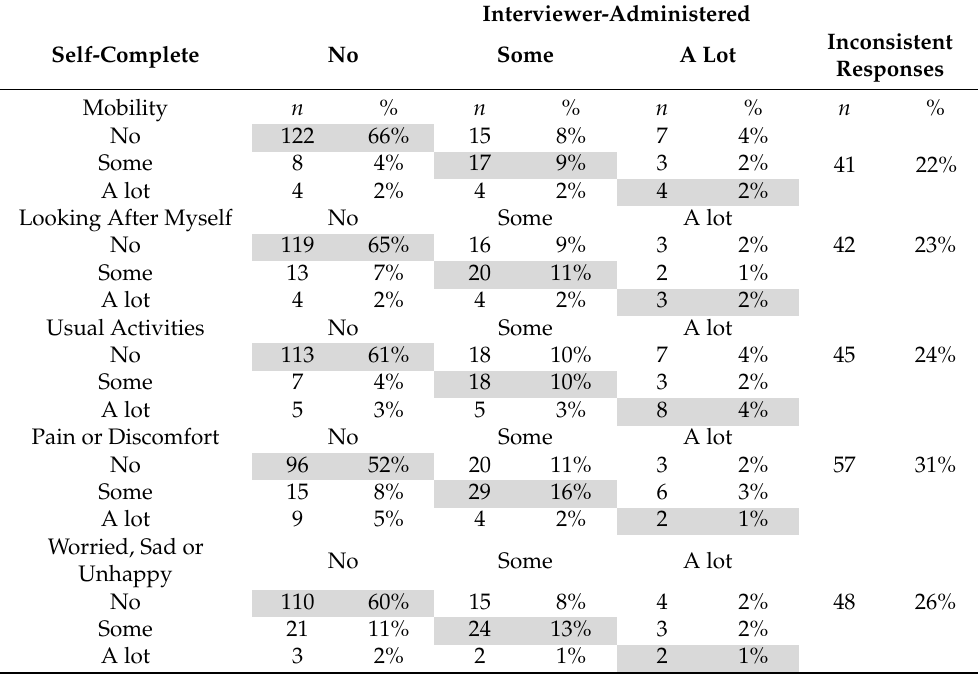
Table 4. Inconsistent responses across dimensions on the self-complete and interviewer-administered dimension versions.